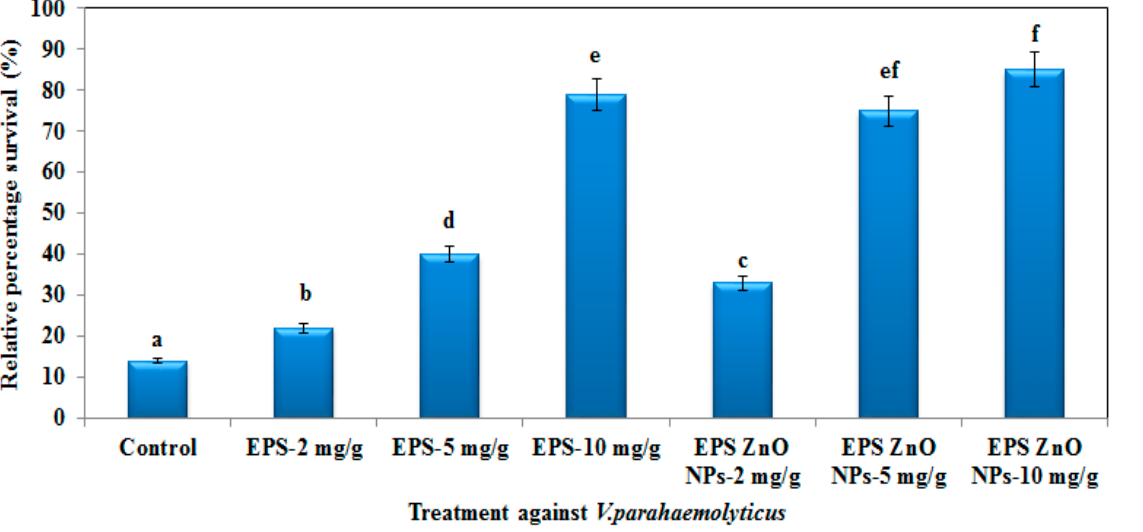
Figure 11. The survival rate of O. mossambicus fed with EPS and EPS-ZnO NPs against A. hydrophila ( A ) and V. parahaemolyticus ( B ). T-bars indicate three replicates of mean ± SD, and different letters correspond to the statistical difference between treated groups.